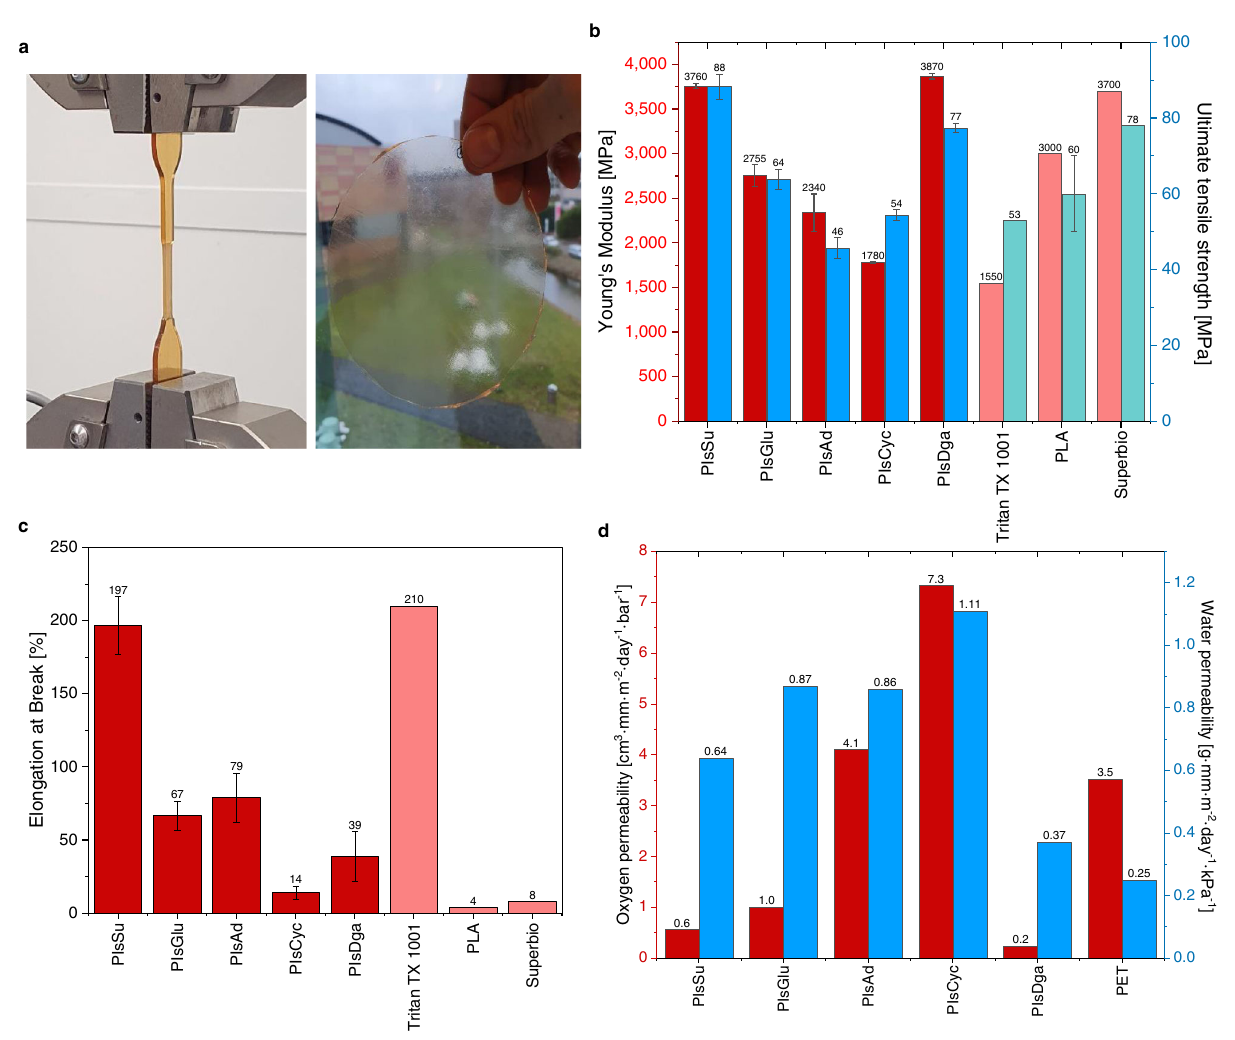
Fig. 5 | Barrier and mechanical properties of isosorbide-based polyesters. a Pictures of a PIsSu tensile bar during tensile testing and a PIsSu polymer fi lm. b Young ’ s Modulus and ultimate tensile strength of isosorbide-based polyesters. Shown values are averaged from three measurements. PIsSu values were deter- minedwithsamplessynthesizedinthe2Lautoclave.ReferencevaluesforTritanTX 1001,PLAandSuperbioweretakenfromtheliterature 20 – 22 . c Elongationatbreakof